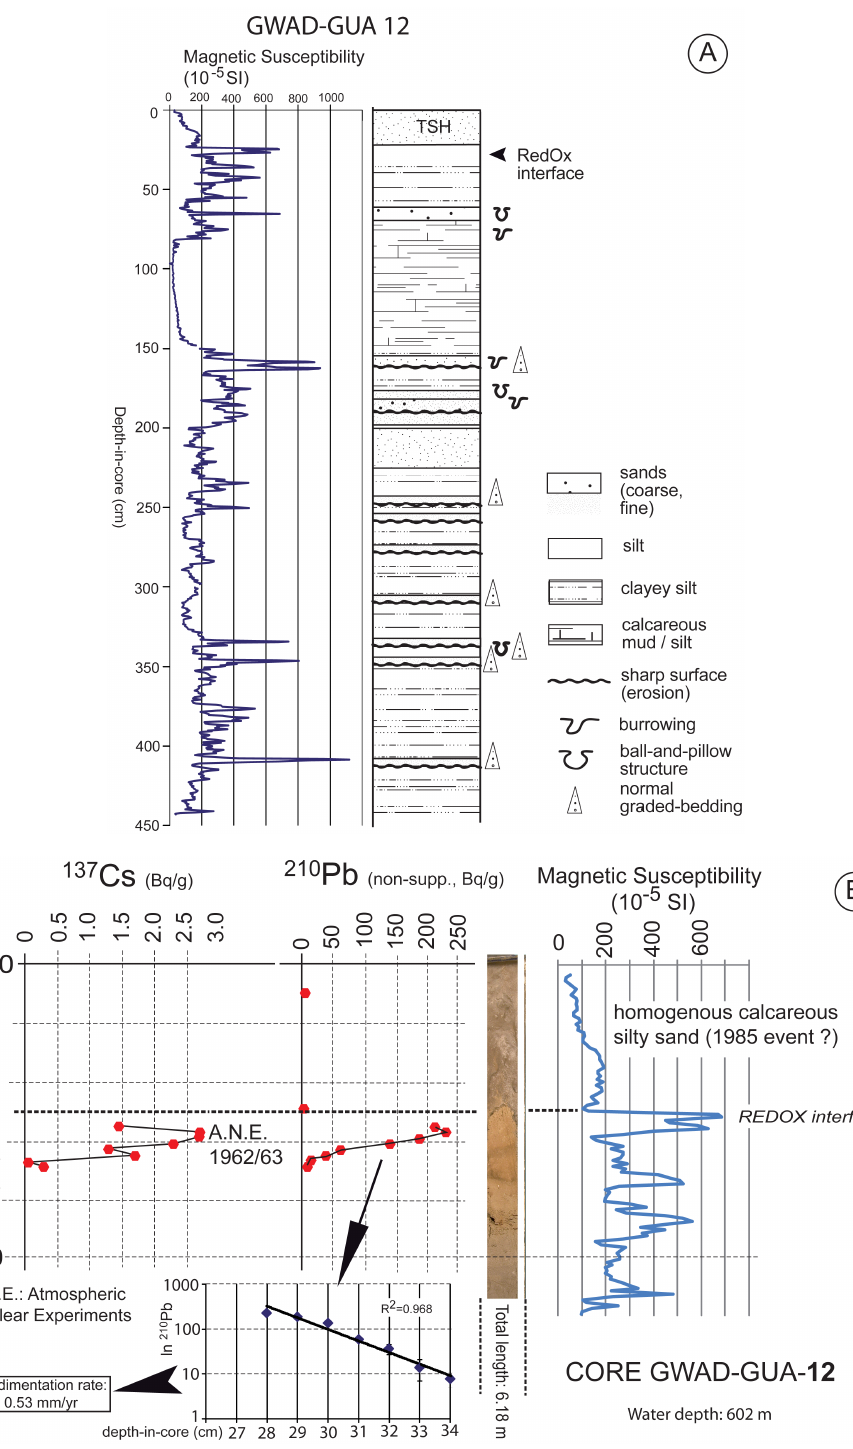
Fig. 6. Lithology, magnetic susceptibility, and radionuclides profiles of Core GWAD-GUA 12. (A) simplified lithology and magnetic susceptibility profile; (B) detail of the top 50cm and radionuclides profiles. The radionuclides activities indicate that the brownish part between 25 and 35cm represents the recent RedOx interface of a slow hemipelagic sedimentation. The 210 Pb decrease (ln. 210 Pb activity vs. depth; lower graph) is used to estimate the sedimentation rate in the concerned hemipelagic interval.